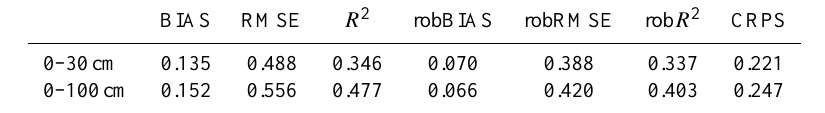
Table 2. Statistics of relative prediction errors of soil organic carbon (SOC) stocks in two depth compartments (0–30, 0–100cm) for the validation set.